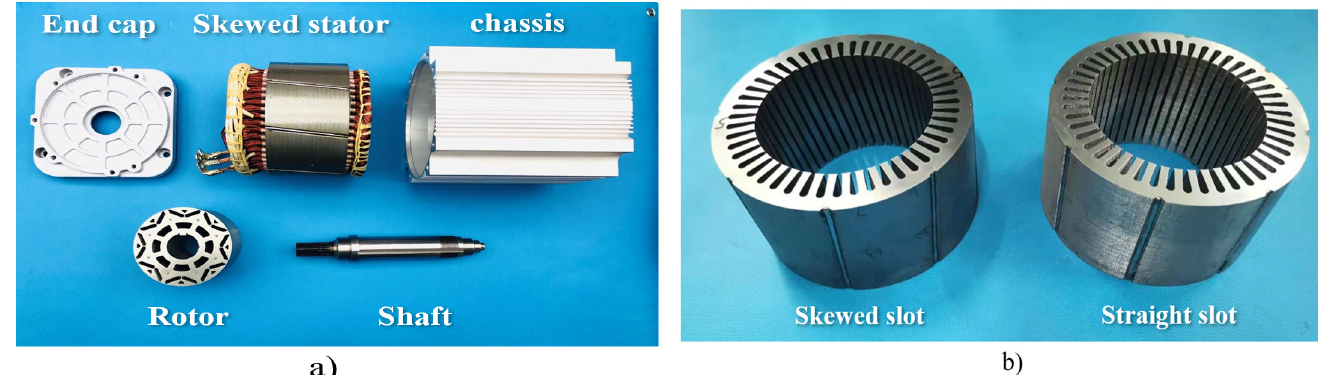
Figure 10. ( a ) The prototype assembly diagram; ( b ) the stator structure.